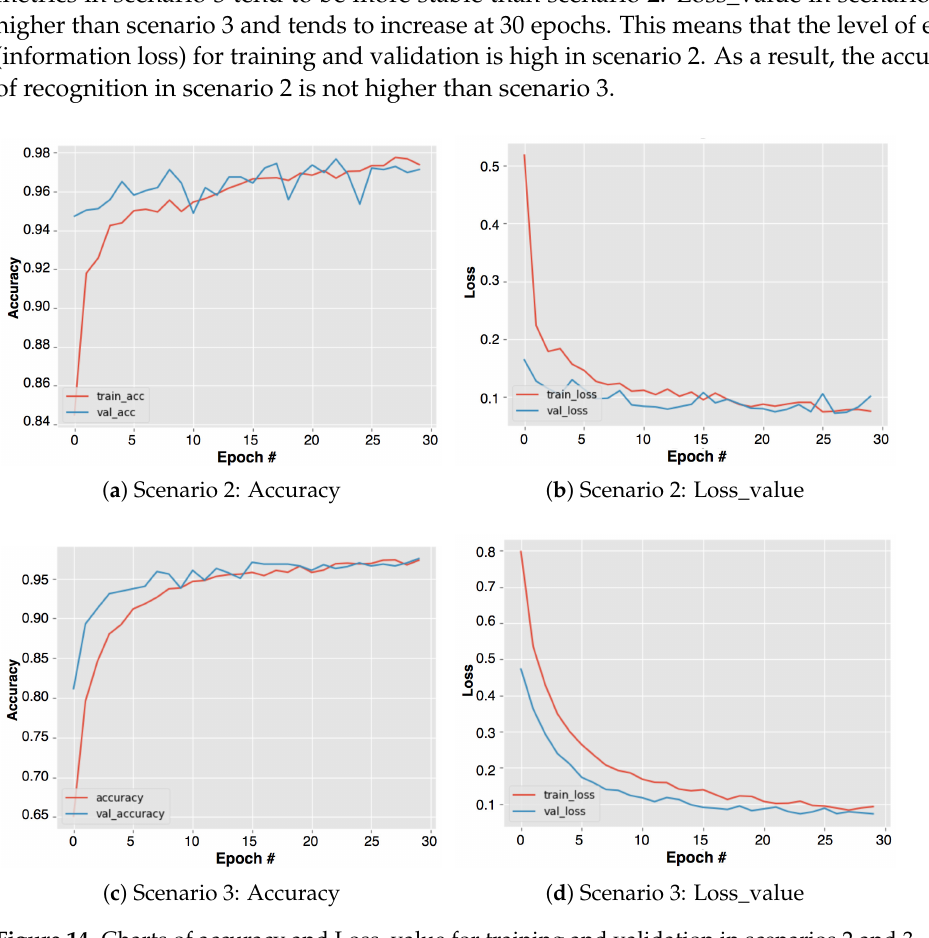
Figure 14. Charts of accuracy and Loss_value for training and validation in scenarios 2 and 3. Training